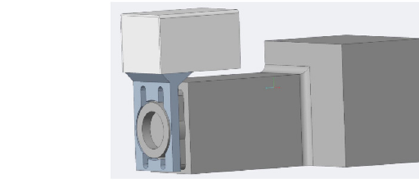
Figure 2. Sensor integration in the machine (image source: [26].)